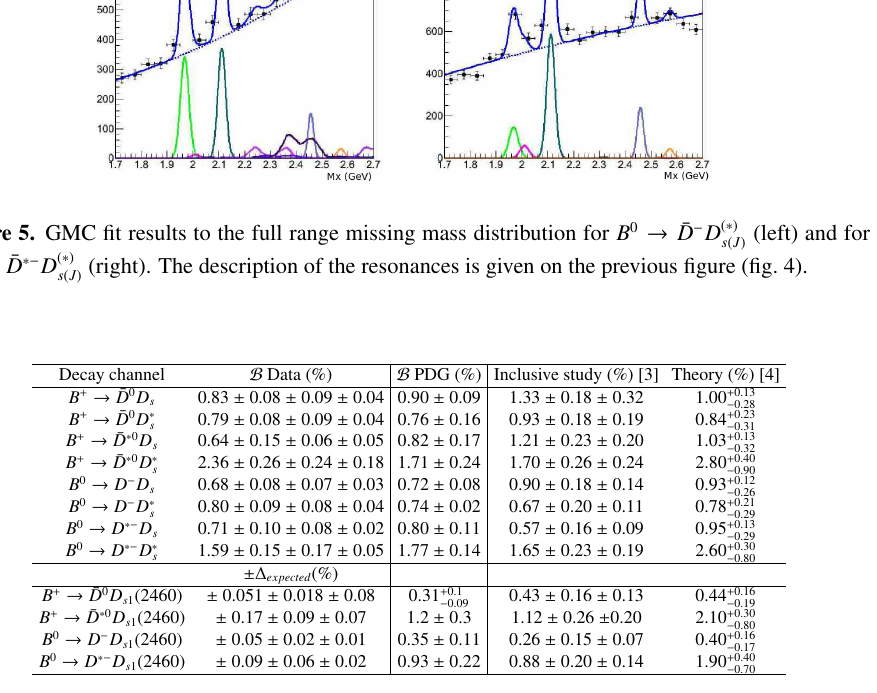
Table 1. Comparison of the measured branching ratios with the PDG values [2], inclusive measurements of the BaBar experiment [3] and theoretical predictions [4]. The uncertainties quoted are due to statistics (first), experimental systematic (second) errors and uncertainties of branching fractions for the decays of intermediate resonances for a given channel